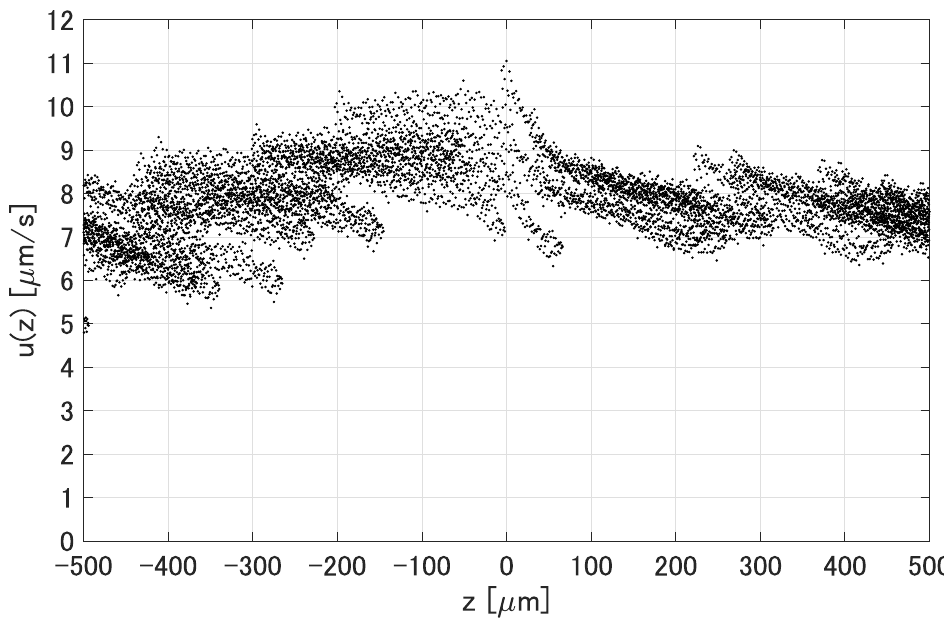
Figure 11. Flow velocity distribution near a prototype.